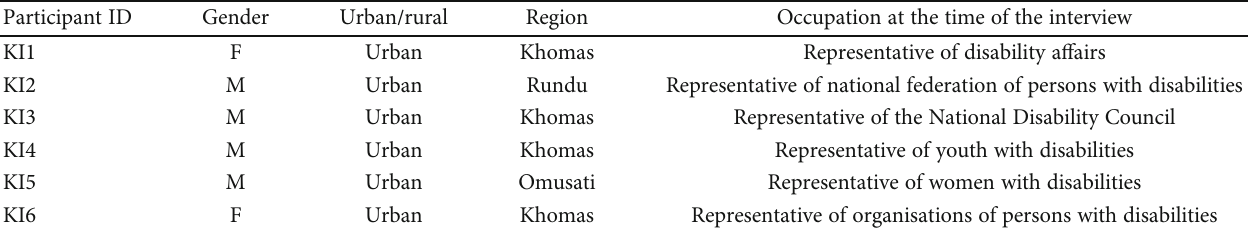
Table 4: Summarised description of key informants with disabilities interviewed ( n = 6